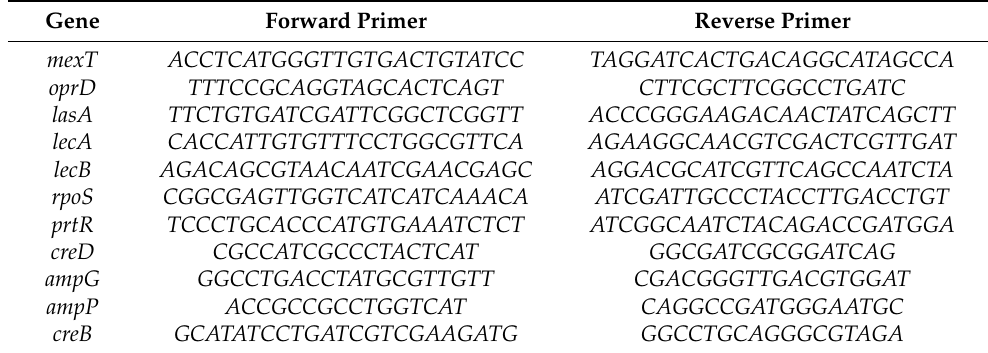
Table 3. Gene and primers used for quantitative reverse-transcriptase polymerase chain reaction (sequence 5 (cid:48) -3 (cid:48)